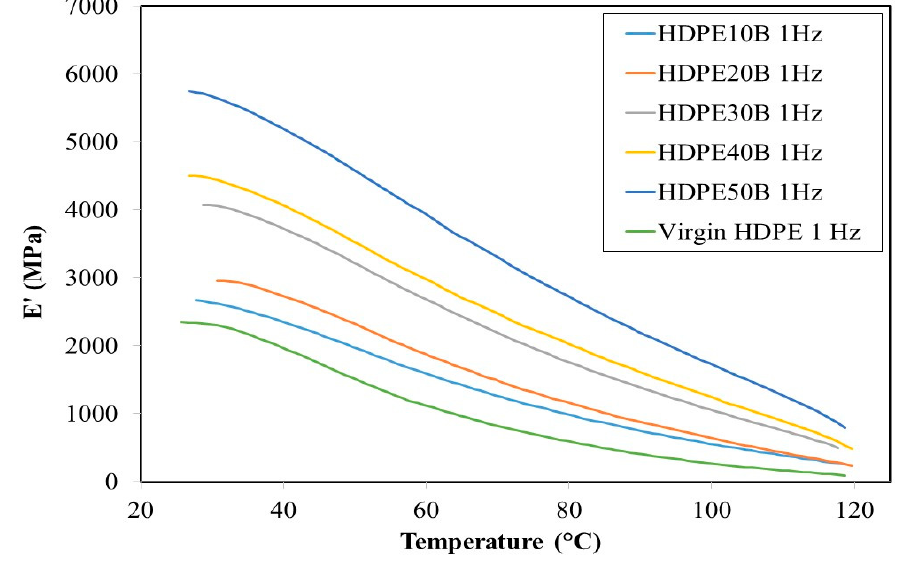
Figure 6. Storage modulus of HDPE/birch fiber composites at 1 Hz.